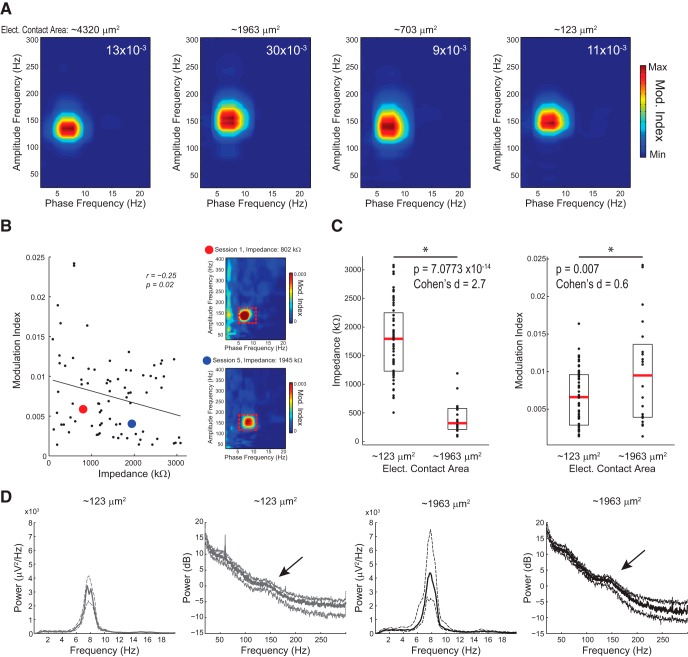
Electrode impedance does not considerably influence comodulation assessment. A, Phase-amplitude comodulograms computed for parietal cortex LFPs recorded during REM sleep from four electrode types differing in contact area. Top right numbers denote maximum modulation index (Mod. Index). Electrode type and material, from left to right: linear planar silicon probe, tungsten single wire, linear planar silicon probe, platinum-iridium tetrode wire. Each comodulogram was obtained from one recording session in one animal (three different animals were used; the single and tetrode wire recordings were from the same animal and session). B, Left, scatter plot of electrode impedance and theta–HFO modulation index. Data obtained from 16 electrodes positioned in the parietal cortex in the same animal across five sessions. The thick line depicts the linear fit. Right, example comodulograms obtained from the same electrode in sessions 1 and 5 (red and blue circles in the scatter plot; electrode area: 123 μm2); red dashed box indicates region used to compute the strength of theta–HFO comodulation. Note a substantial increase in impedance along with a mild decrease in comodulation. C, Electrode impedance (left) and theta–HFO modulation index (right) measured for electrodes of 123 μm2 (n = 12) and 1963 μm2 (n = 4) contact area across five sessions for the same animal as in B. Boxes indicate 25th and 75th percentiles, red trace denotes the median, and dots show individual values. Note that although larger electrodes have much lower impedance, comodulation strength does not differ as much. D, Mean power spectra for the same recordings as in B and C. Thick and dashed lines represent median and 25th–75th percentiles, respectively. Arrows highlight a power peak in the HFO range in both electrode types.